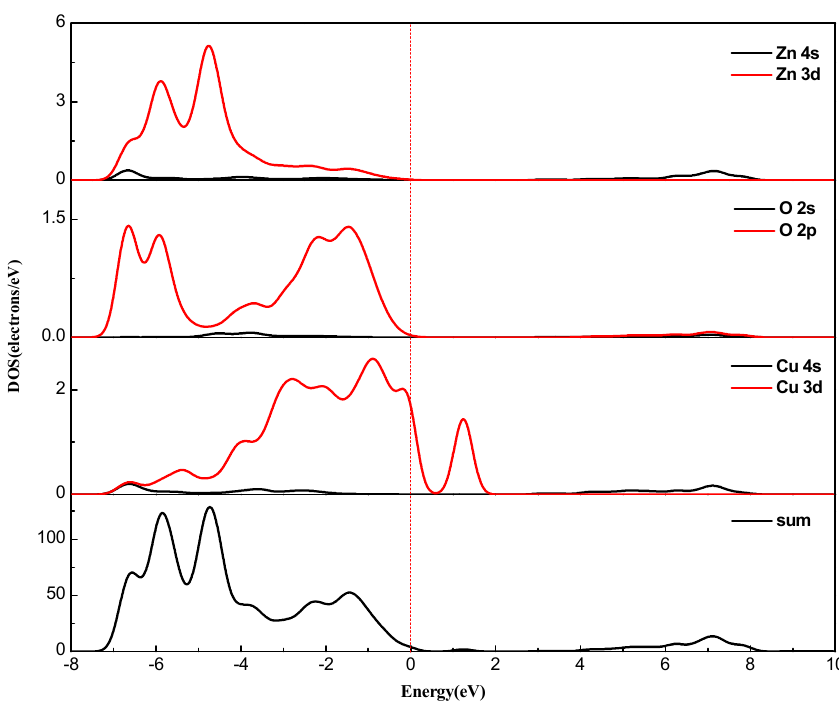
Figure 7. PDOS of Cu 0.0417 Zn 0.9583 O.